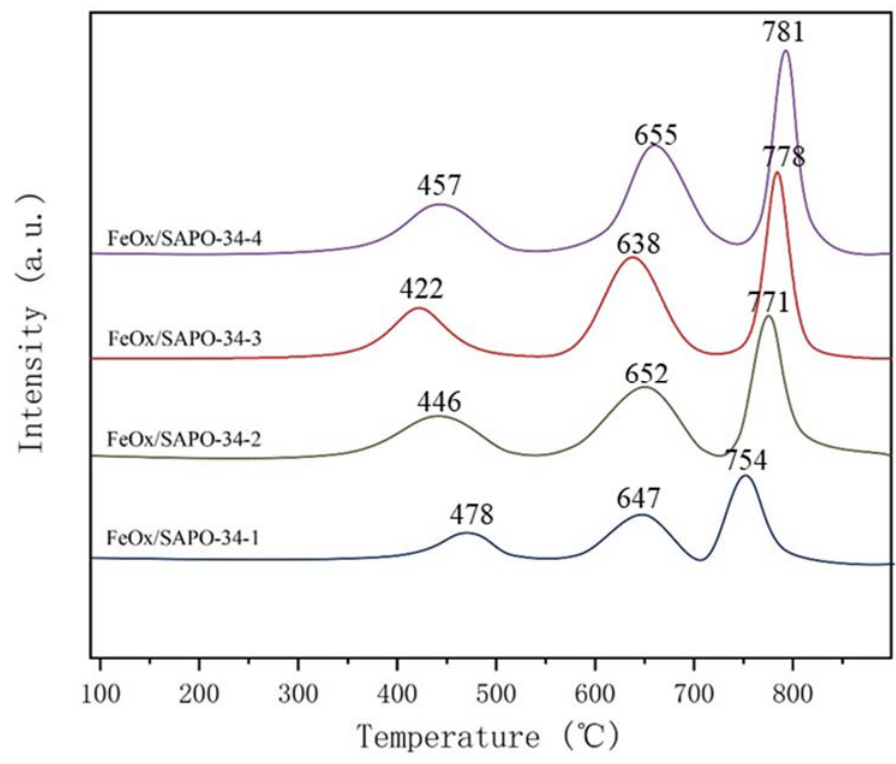
Figure 5. H 2 ‐ TPR spectrum of the FeO x /SAPO ‐ 34(x) molecular sieve samples prepared by the im ‐ pregnation method.